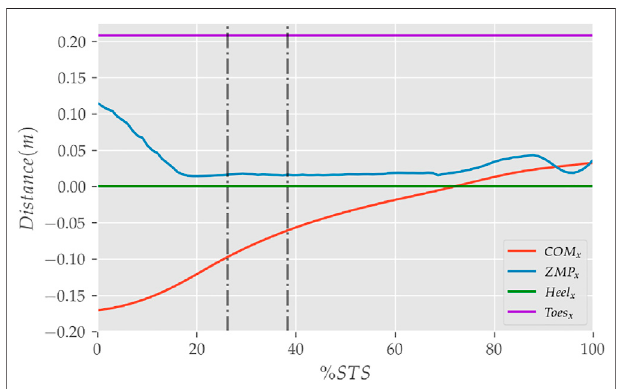
FIGURE 9 | The zero moment point (feet forces) and the body ’ s COM trajectories from the 0% strength de fi cit model ’ s STS transition.